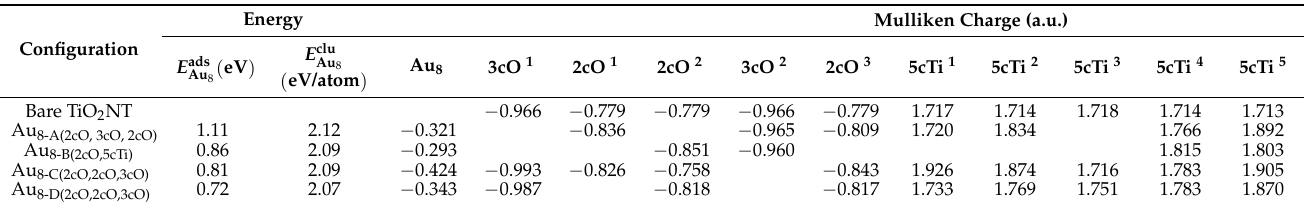
Figure 6. Four adsorption geometries for Au 8 clusters on the TiO 2 NT (6,0) are displayed as ( A – D ). ( a , b ) depict the cross-sectional view and the side view of the Au 8 cluster absorption systems, re- spectively. The cross-sectional views of four adsorption geometries are shown as ( A-a , B-a , C-a , D-a ), respectively. The side vies of four adsorption geometries are shown as ( A-b , B-b , C-b , D-b ), respectively. Table 2. Adsorption and clustering energies of Au 8 and atomic Mulliken charges of Au and TiO 2 NT surface atoms for the Au 8 /TiO 2 NT system in different configurations a